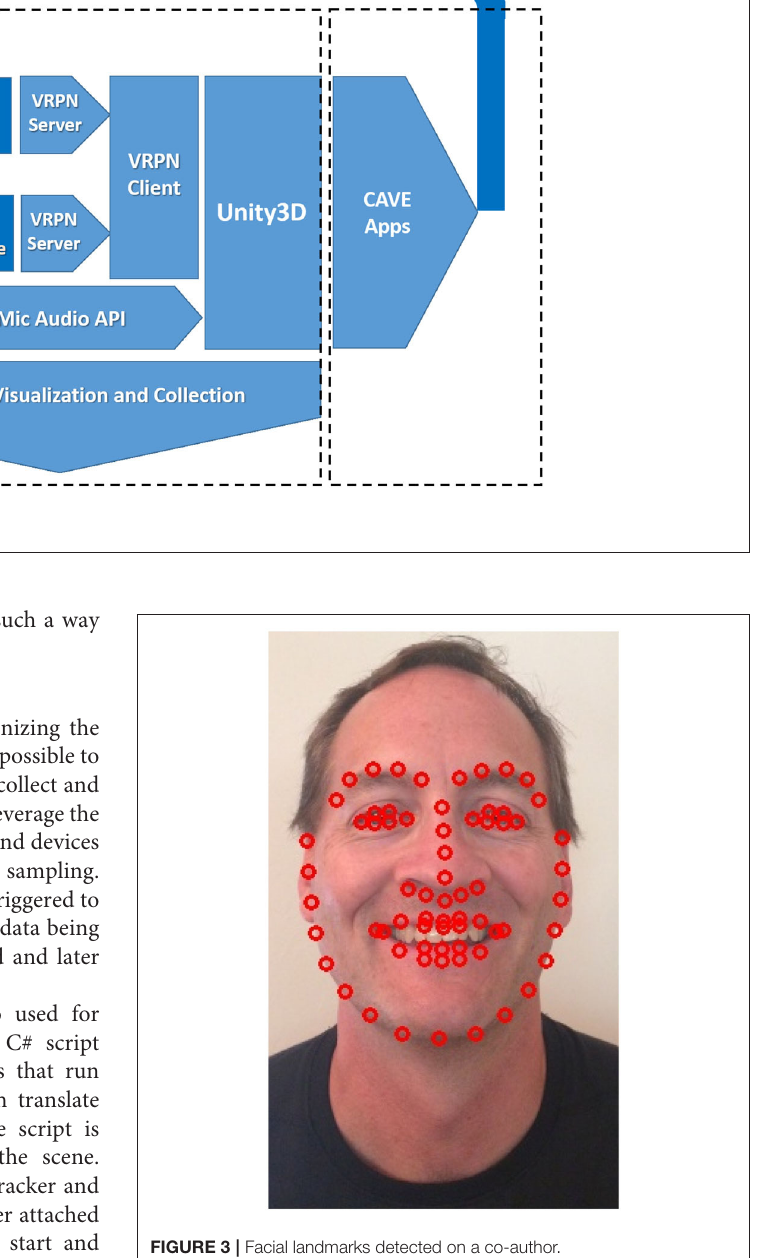
FIGURE 3 | Facial landmarks detected on a